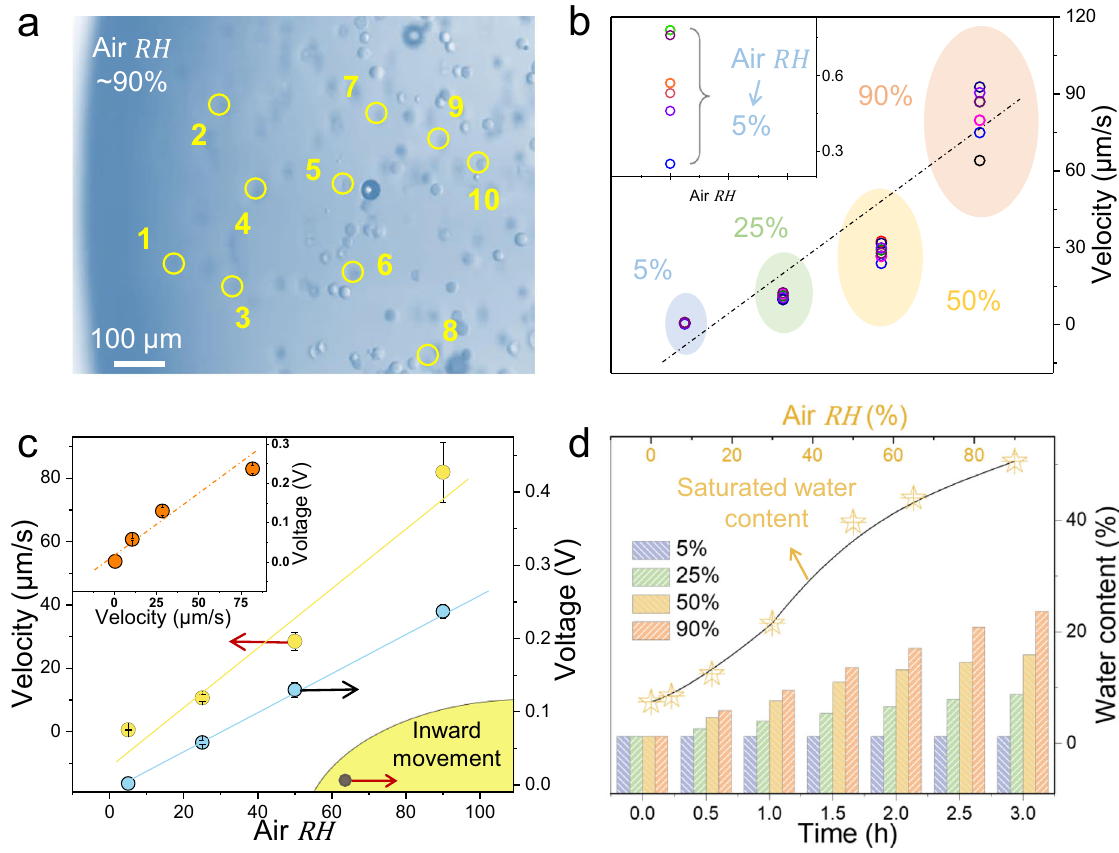
Fig. 4 Dependence of fl ow velocity and output voltage on air humidity. a Snapshot of polystyrene microspheres movement of dry IL under air humidity of 90%. b Statistics of velocity under RH of 5 – 90%. c Averaged velocity and V OC versus RH. Inset is dependence of V OC on inward movement velocity (0 – 80 μ m/s). d WC of dry IL drop versus time and WC S under different RH (25